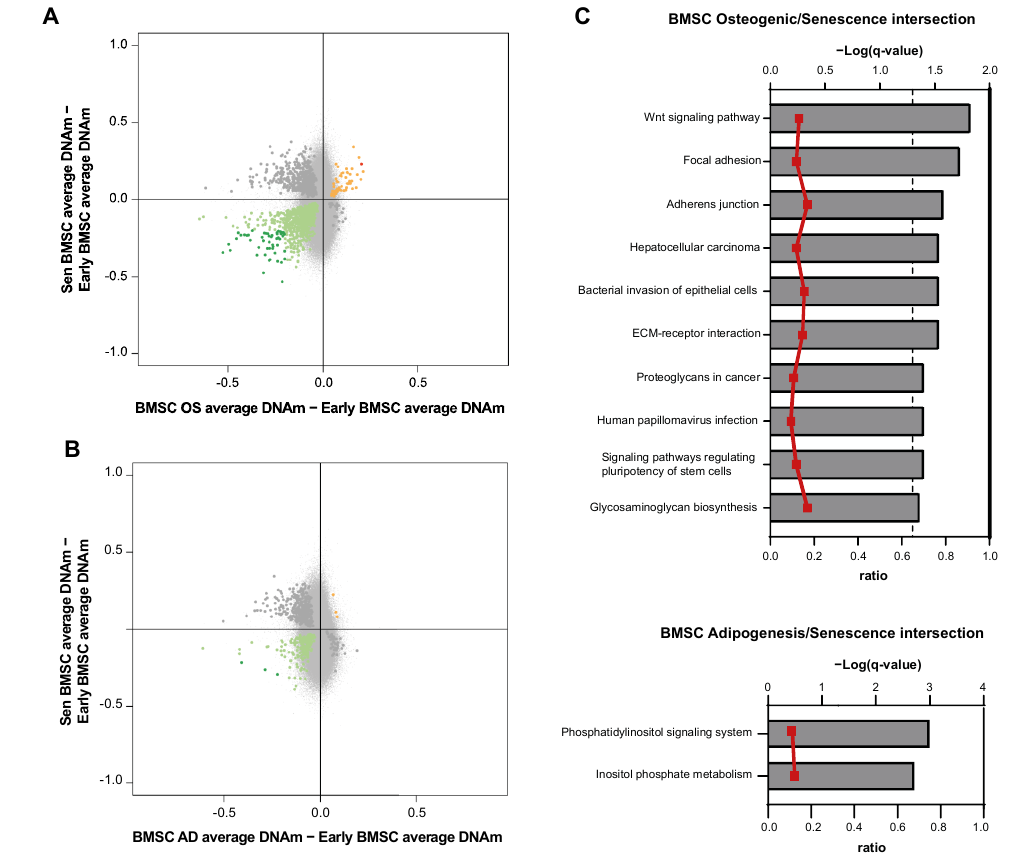
Figure 5. ( A , B ) Scatterplots comparing DNAm differences induced by ( A ) osteogenic (OS) and ( B ) adipogenic (AD) commitment vs. replicative senescence (Sen) of BMSCs. DMPs (FDR < 0.05) with hypo- and hyper-methylation in both the comparisons are indicated in green and red, respectively; DMPs with an absolute DNAm difference >0.20 are highlighted with darker green and red colors. ( C ) KEGG pathways significantly enriched in genes containing DMPs that are common between BMSC osteogenic (upper panel), adipogenic (lower panel) commitment, and replicative senescence. Pathways are ranked according to the significance of enrichment (grey bars, upper y -axis). Ratios referring to the proportion of targeted genes related to the total number of genes in each pathway are displayed (red line graph, bottom y -axis).